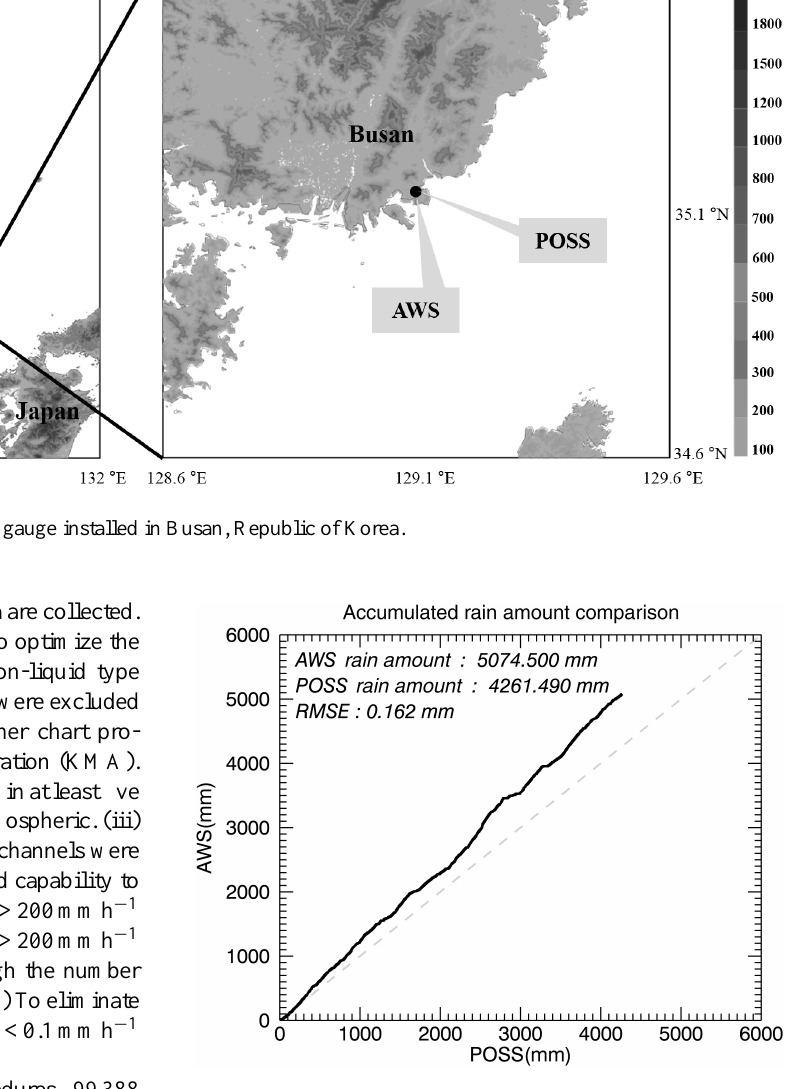
Figure 3. Comparison of the recorded rainfall amounts between the POSS and AWS